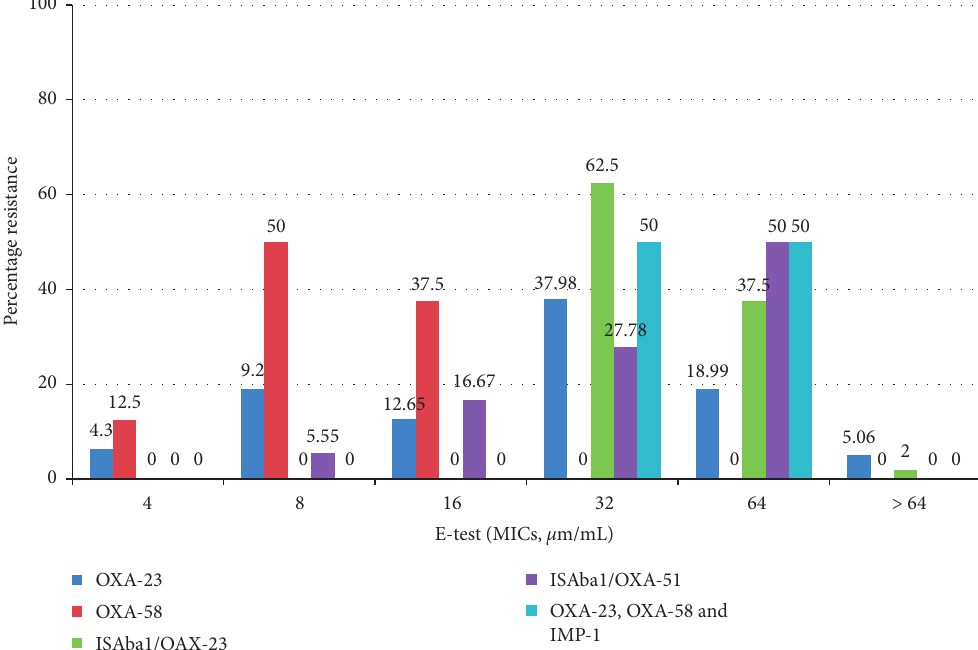
Figure 2: Distribution of imipenem MICs in 100 CRAB isolates with the bla bla OXA-51-like and bla OXA-23-like , bla OXA-58-like and bla IMP-1 genes.